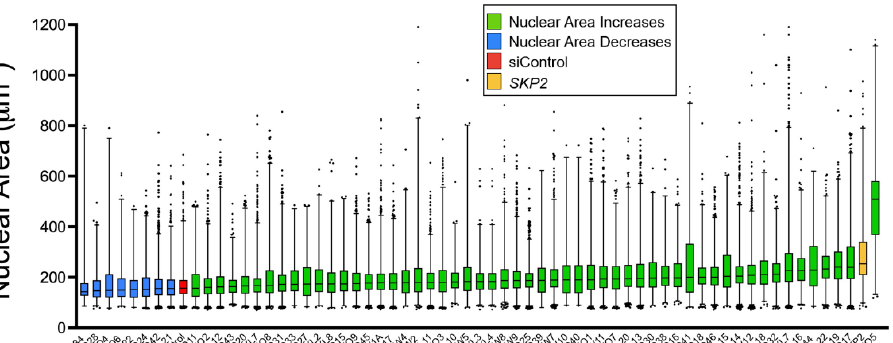
Figure 1. SiRNA-based Screen Identifies SKP2 as a Strong Candidate CIN Gene. Box-and-whisker plot presenting the F-box genes that, when silenced, induce statistically significant differences (two-sample Kolmogorov–Smirnov [KS] tests) in cumulative nuclear area distribution frequencies relative to siControl. Genes are arranged by increasing median nuclear area with boxes identifying the interquartile ranges (25th, 50th, 75th percentiles) and the whiskers denoting the 1st and 99th percentiles. Blue boxes denote significant decreases in nuclear areas, while green boxes denote significant increases in nuclear areas. This screen identified SKP2 as a strong candidate CIN gene (yellow).